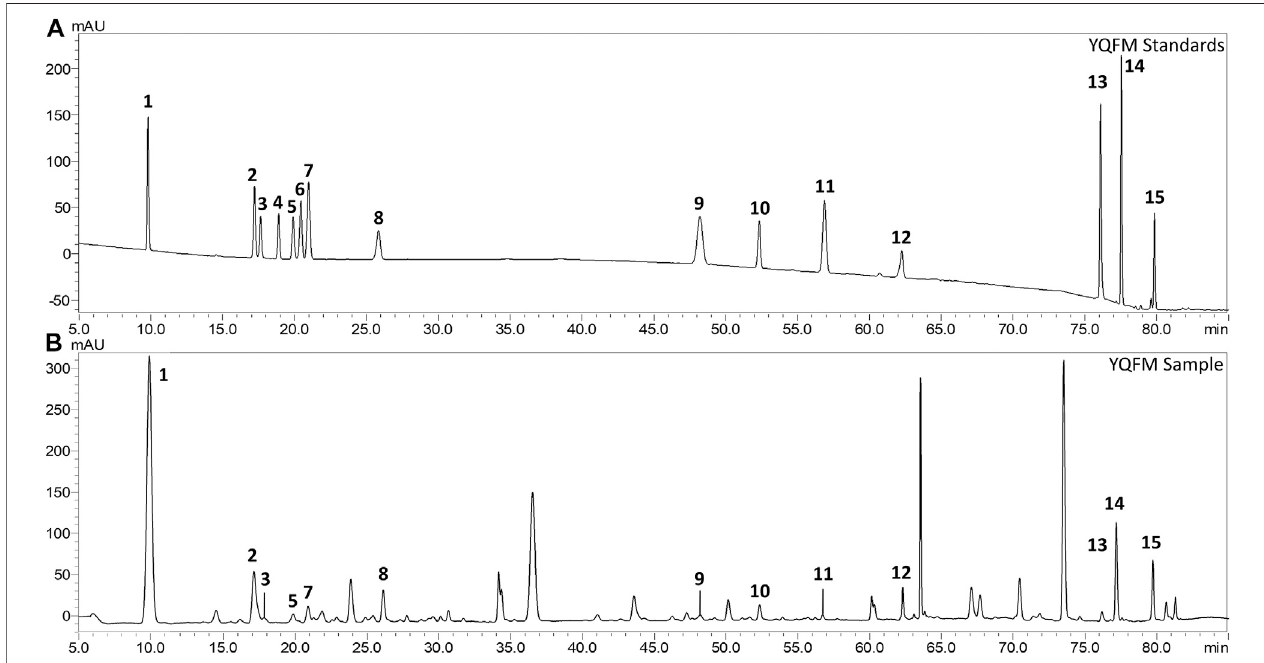
FIGURE 1 | Comparison of the liquid chromatogram of the mixed reference substance and YQFM sample. (A) Standard solution and (B) Sample solution: 1: ginsenoside Rg1, 2: ginsenoside Rf, 3: ginsenoside Rb1, 4: ginsenoside Rc, 5: ginsenoside Rb2, 6: ginsenoside Rb3, 7: ginsenoside Re, 8: ginsenoside Rd, 9: schizandrol A, 10:20(S)-ginsenoside F2, 11: schizandrol B, 12: ginsenoside Rg2, 13: schisandrin A, 14: schisandrin B, 15: ginsenoside Rh1.